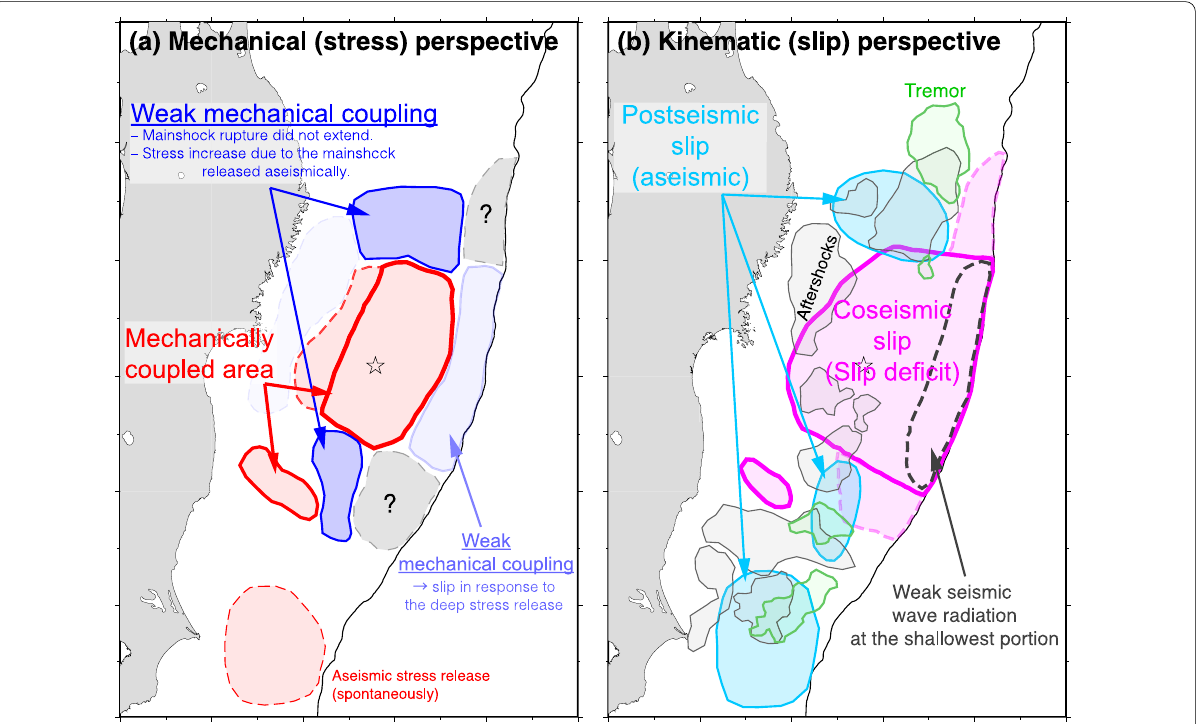
Fig. 13 Interpretation of the mechanical and kinematic properties along the Tohoku plate boundary. a Mechanical perspective associated with the megathrust Tohoku-Oki earthquake. The regions where the plate boundary is mechanically locked are shown in red, and the regions where the mechanical coupling is weak are shown in blue. The regions surrounded by dashed lines are less certain than those with the solid lines. The regions where the mechanical property is unclear are shown in gray. b Kinematic perspective of the seismic activities along the plate boundary. The spatial relationship of the coseismic (magenta) and postseismic (cyan) slips are shown. Aftershock areas are also shown in gray, and tremor areas are shown in